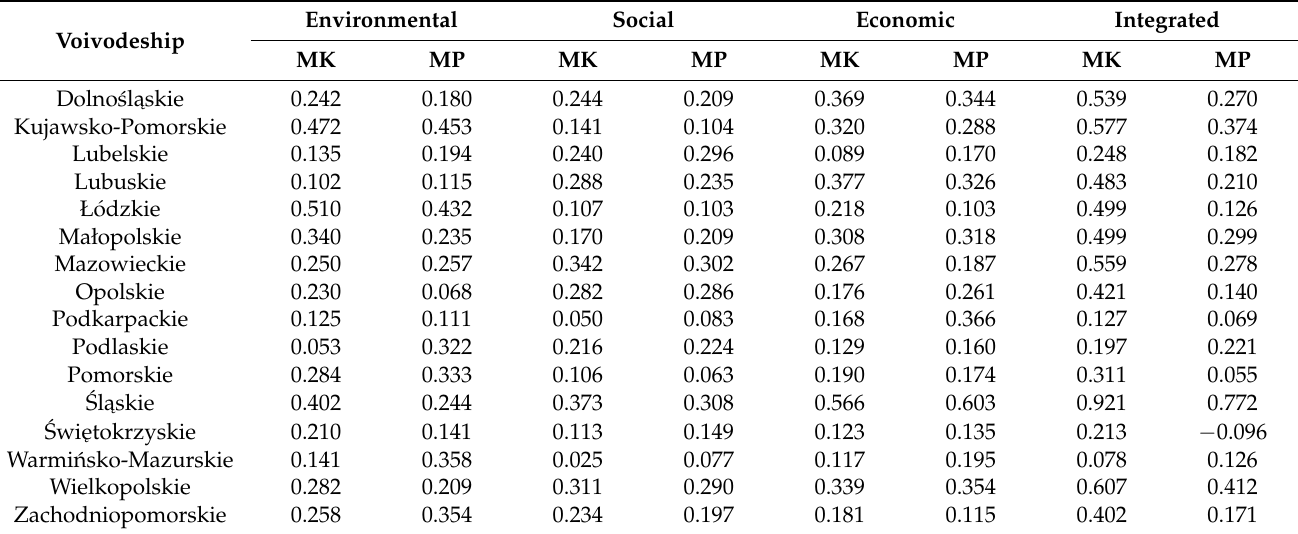
Table 4. Values of synthetic measures according to particular orders for analyzed